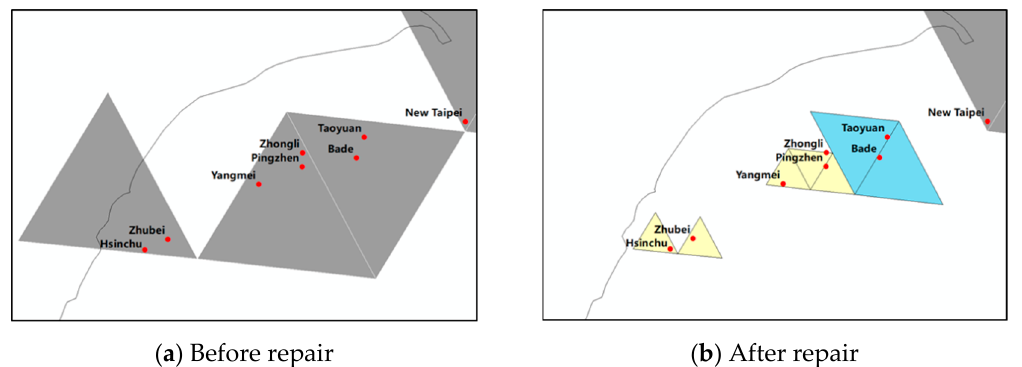
Figure 14. An example of topology distortion repair of point features by gridding.